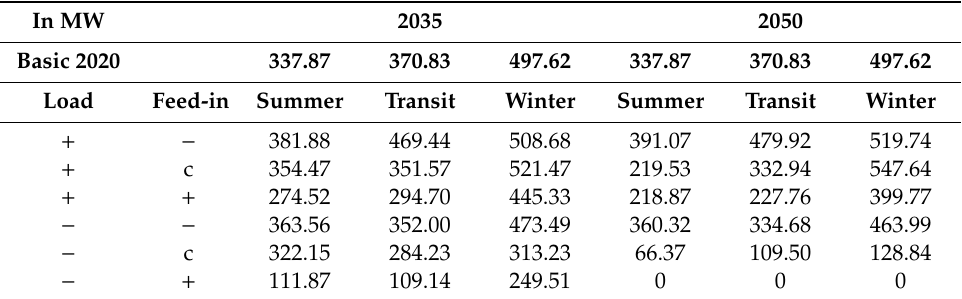
Table 5. External inflows E i to the Baden-Württemberg grid for di ff erent future scenarios. In MW